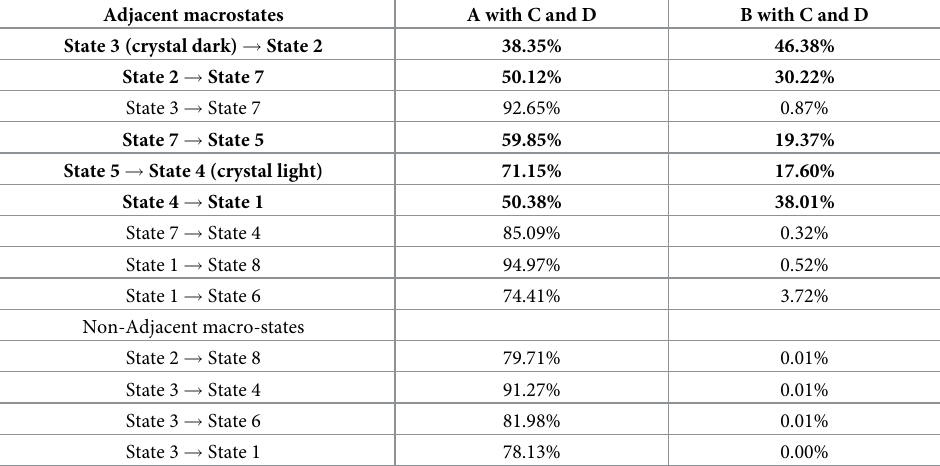
Table 3. The changes of Commu. A and Commu. B during transitions between states. (Bolded is state-transitions with large Commu B